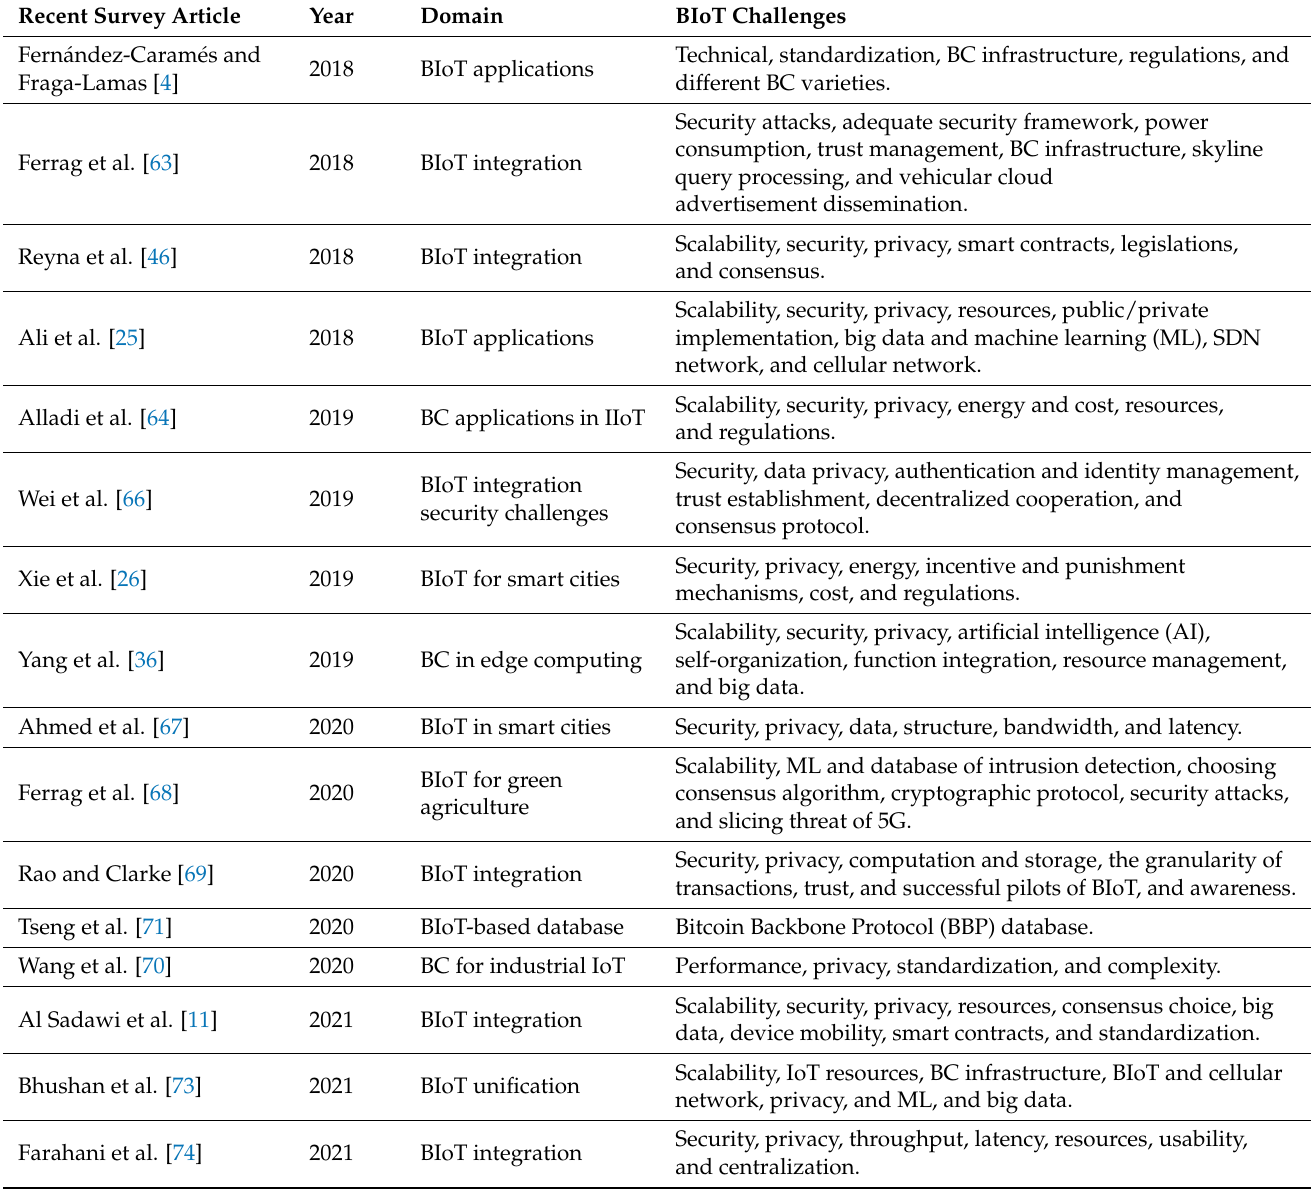
Table 4. BIoT integration challenges—survey